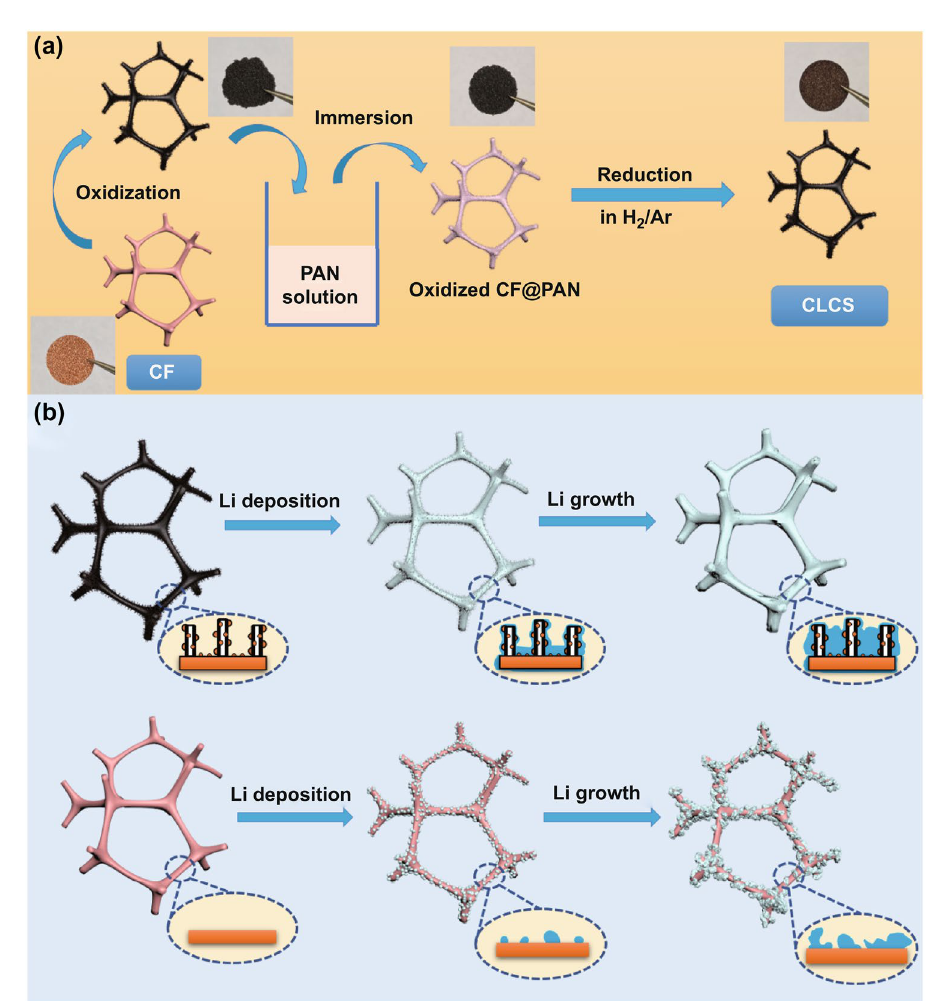
Fig. 1 a Schematic diagrams for the synthetic process of CLCS. b Different Li deposition and growth behaviors in bare CF and